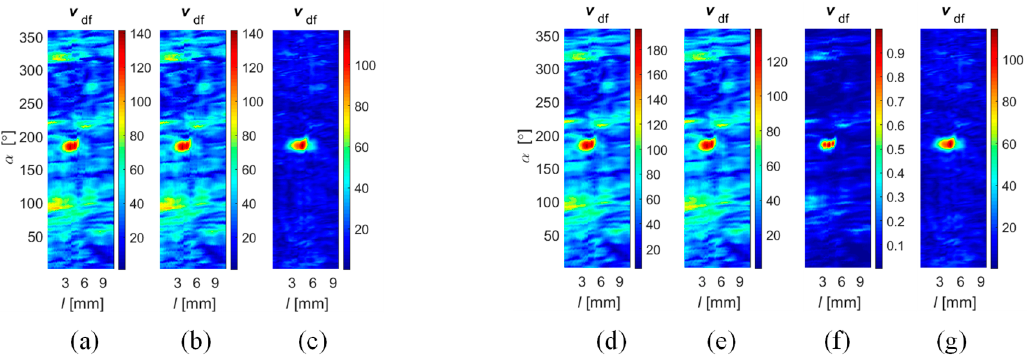
Figure 16. Results of Stage II ( v ndf ) of data fusion obtained for the 0.5 mm circumferential d 4 defect achieved for angular range of each sensor equal to 45° and using algorithms ( a ) DF vec ; ( b ) DF SF ; and ( c ) DF PYR ; and for angular range equal to 90° and using algorithms ( d ) DF vec ; ( e ) DF SF ; ( f ) DF IOP , and ( g ) DF PYR .